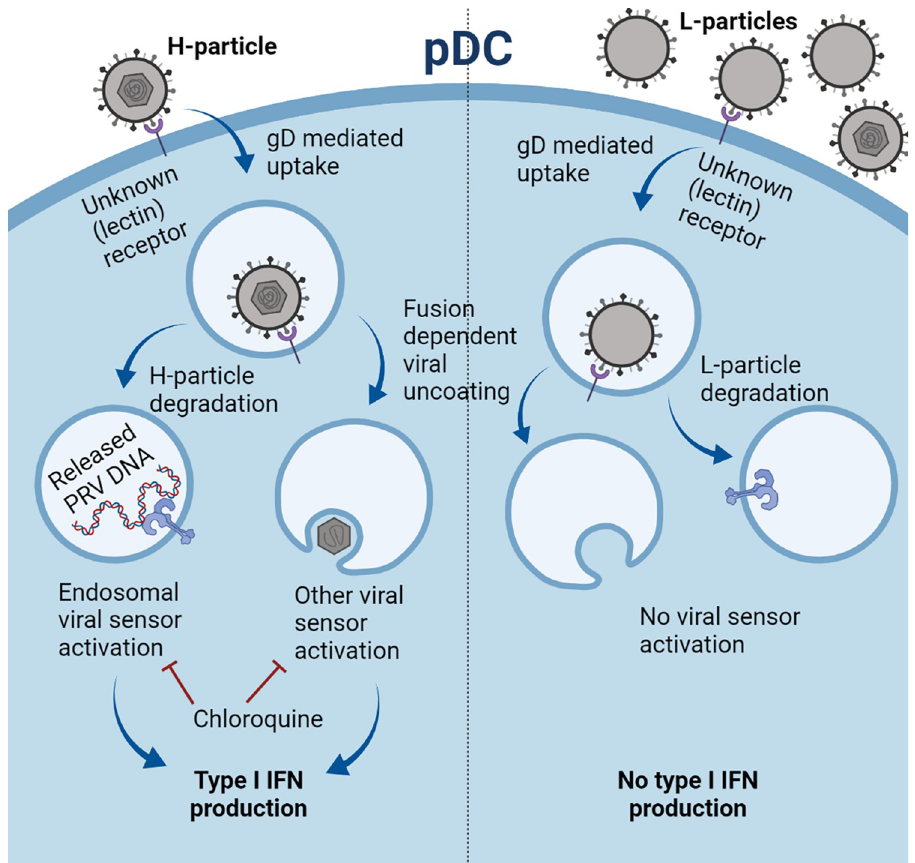
Fig 9. Hypothetical model of PRV H-particle induced activation and L-particle mediated inhibition of pDC. (Left) DNA-containing PRV H-particles trigger endosomal acidification- and viral gD glycoprotein-dependent activation of pDC. The viral fusion machinery contributes to but is not essential for pDC activation. (Right) DNA- and capsid- lacking viral L-particles suppress H-particle-induced activation of pDC in a competitive and gD-dependent manner. Created with